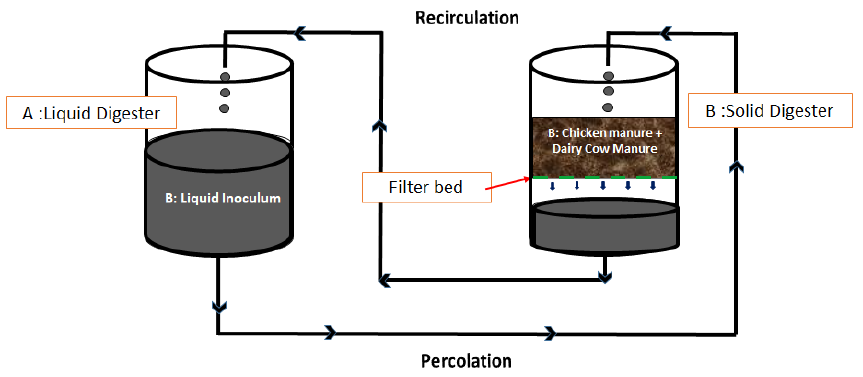
Figure 1. Schematic diagram of a single set of two-stage (liquid–solid) digesters.